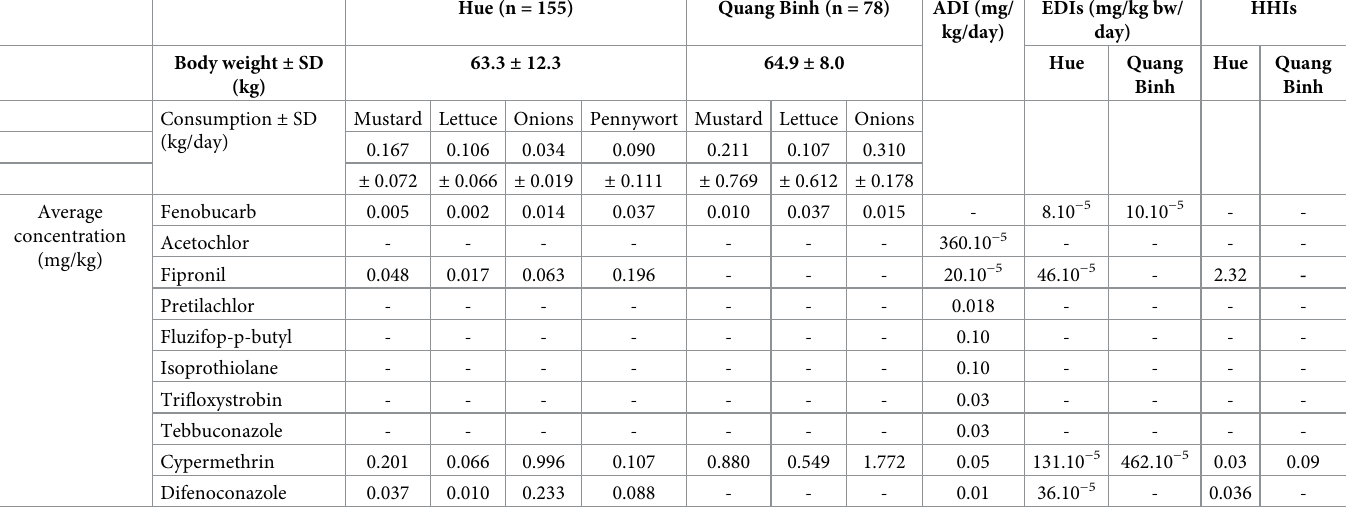
Table 4. Health risk of pesticide residues in vegetables collected in Thua Thien Hue and Quang Binh provinces.